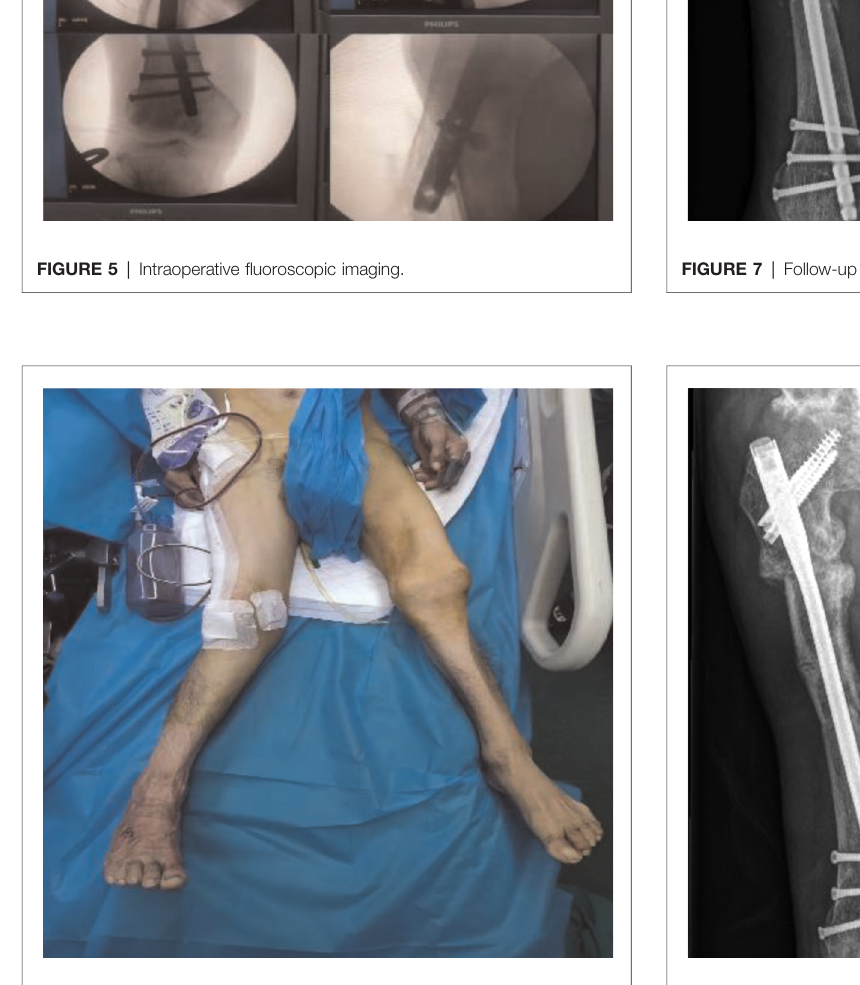
FIGURE 6 | Postoperative external image.